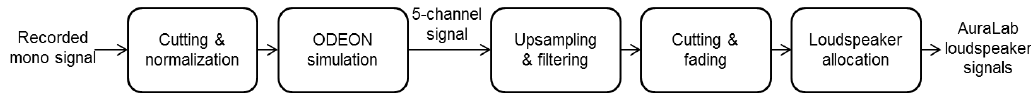
Figure 2. Block diagram of the signal processing steps from recording to